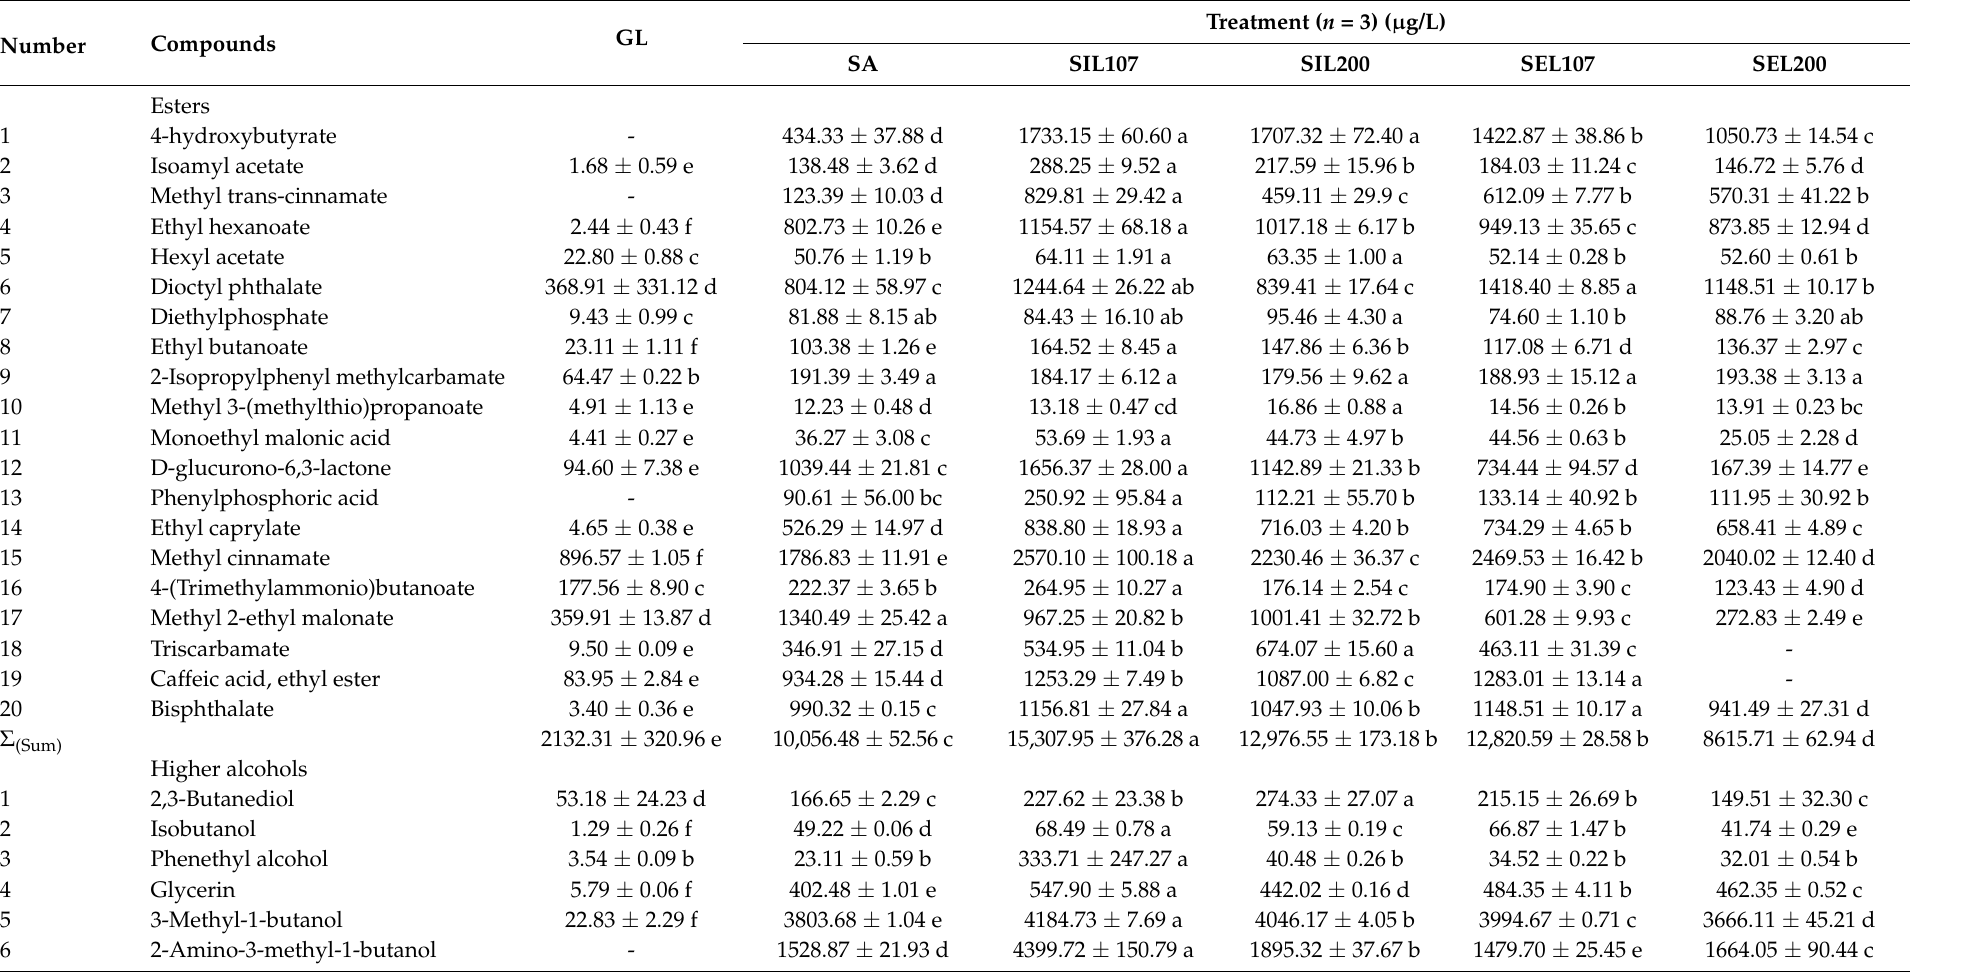
Table 1. Volatile compounds of apple juice and ciders produced by pure and mixed culture